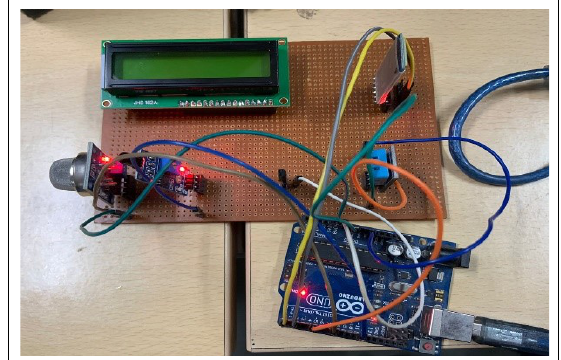
Fig. 5 : Prototype Of Monitoring System in Coal Mine